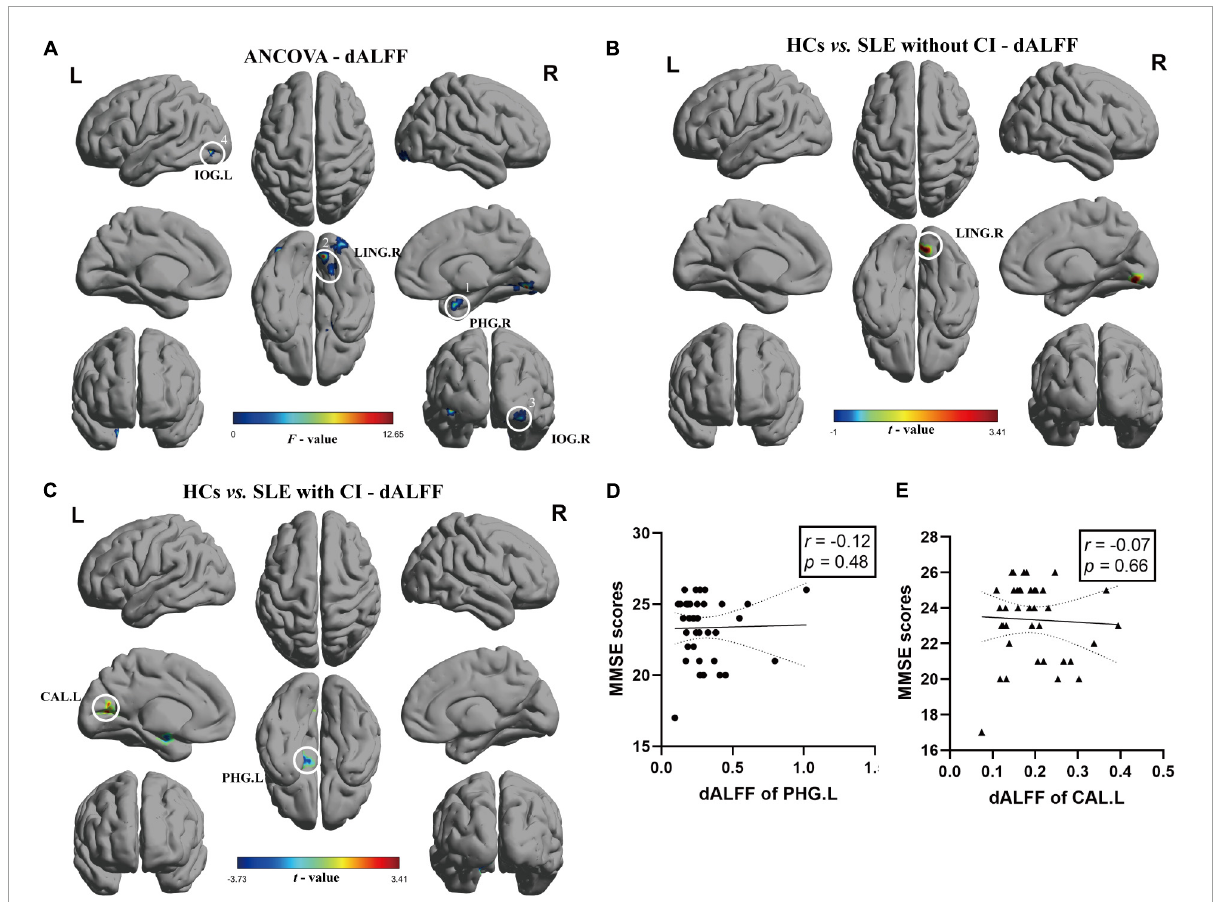
FIGURE2 Brain regions with significant differences of dALFF among SLE with CI, SLE without CI, and HCs. Specifically, (A) ANCOVA results of dALFF among three groups (voxel P < 0.01, cluster P < 0.05, controlling for age, gender, and head motion, GRF corrected). (B,C) Differences between the groups were calculated using post-hoc analysis based on a two-sample t -test (voxel P < 0.01, cluster P < 0.05, controlling for age, gender, and head motion, GRF corrected). (D,E) Correlation analysis showed no significant correlation was found between dALFF and MMSE scores in SLE with CI groups. Color bars represent statistical value; the solid lines and dashed lines represented the linear regression fitted line and 95% confidence interval of the Spearman correlation analysis, respectively, SLE with CI, systemic lupus erythematosus patients with cognitive impairment; SLE without CI, systemic lupus erythematosus patients without cognitive impairment; HCs, healthy controls; dALFF, dynamic amplitudes of low-frequency fluctuation; MMSE, Mini-mental State Examination; L, left hemisphere; R, right hemisphere; PHG, para hippocampal gurys; LING, lingual gyrus; IOG, inferior occipital, putamen; CAL, calcarine fissure and surrounding